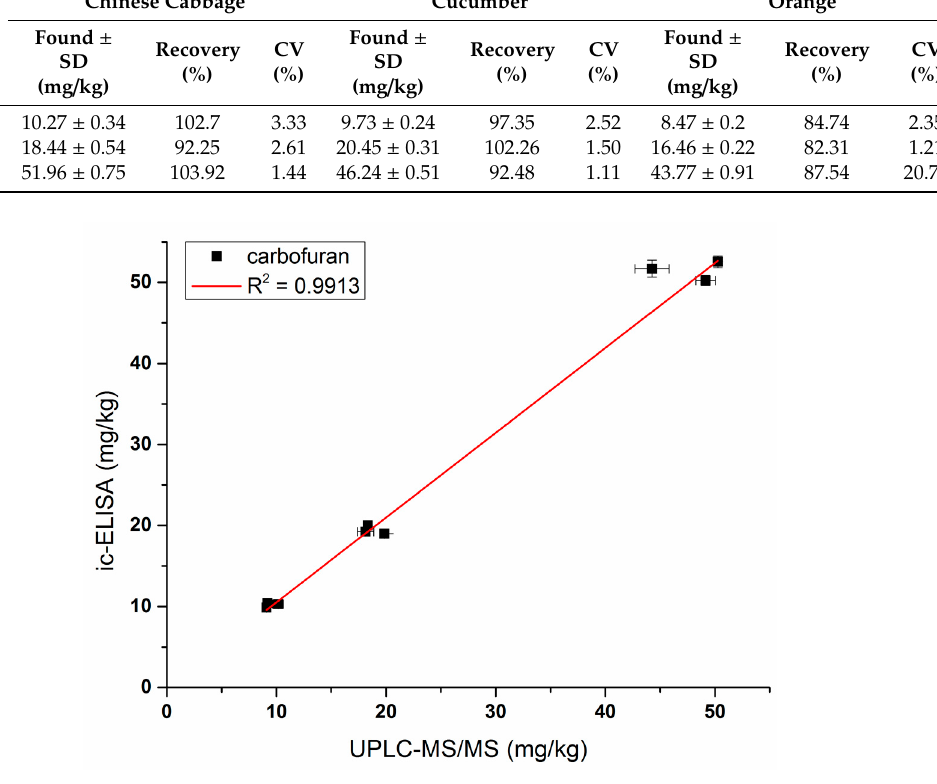
Figure 7. Correlations of analysis of samples spiked with carbofuran between Nb316-based ic-ELISA and UPLC–MS/MS.